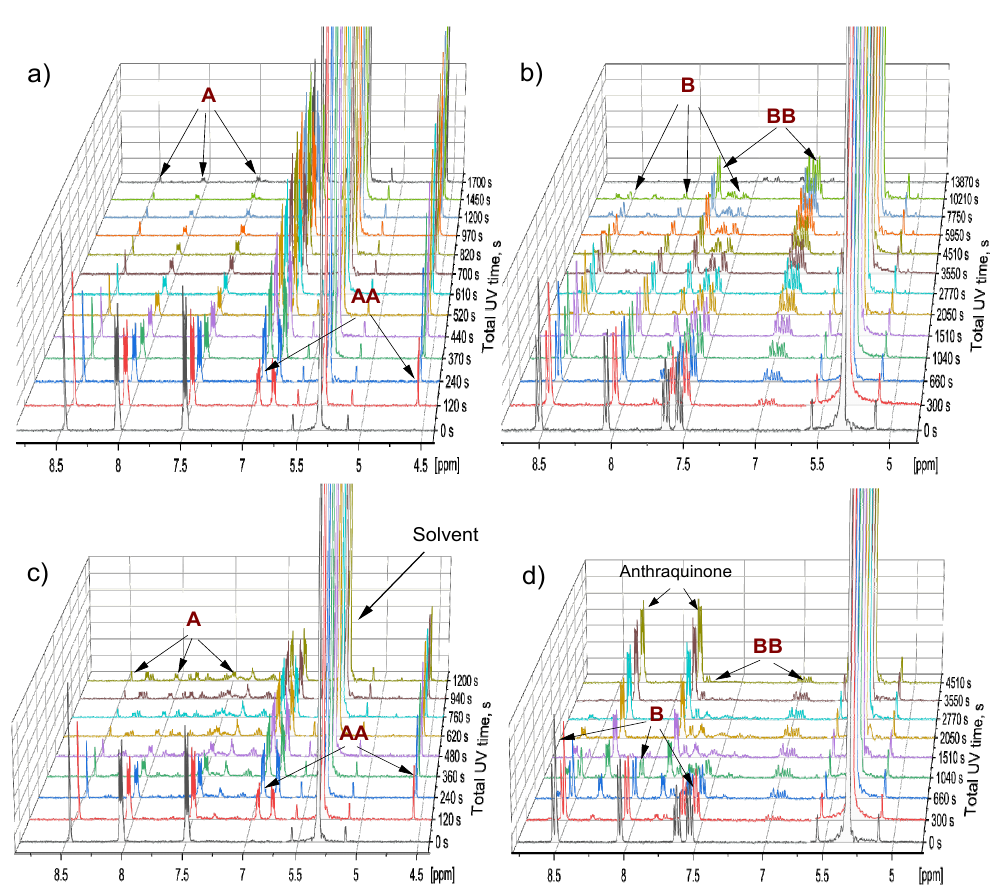
Figure 5. The 400 MHz 1 H-NMR spectra of anthracene ( A ), dimer of anthracene ( AA ), 9-bromoanthracene ( B ) and dimer of 9-bromoanthracene ( BB ) in: ( a , b ) deoxygenated samples and ( c , d ) samples with oxygen at different reaction times, i.e., total time of UV illumination ( λ = 365 nm).